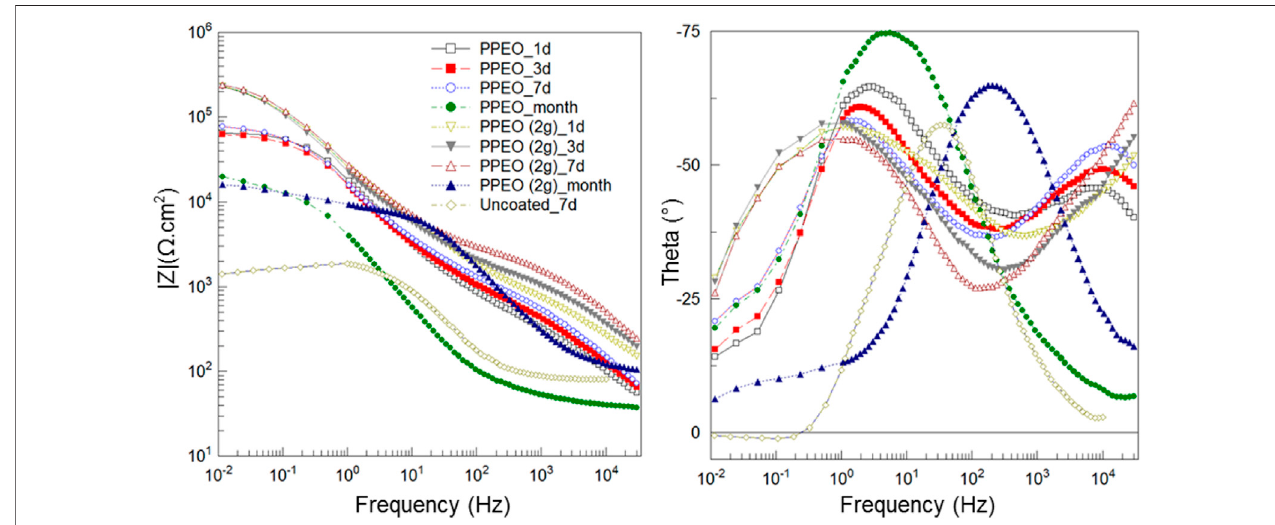
FIGURE 4 | Electrochemical impedance performance of PPEO and PPEO (2 g_particle) in Hank ’ s solution.